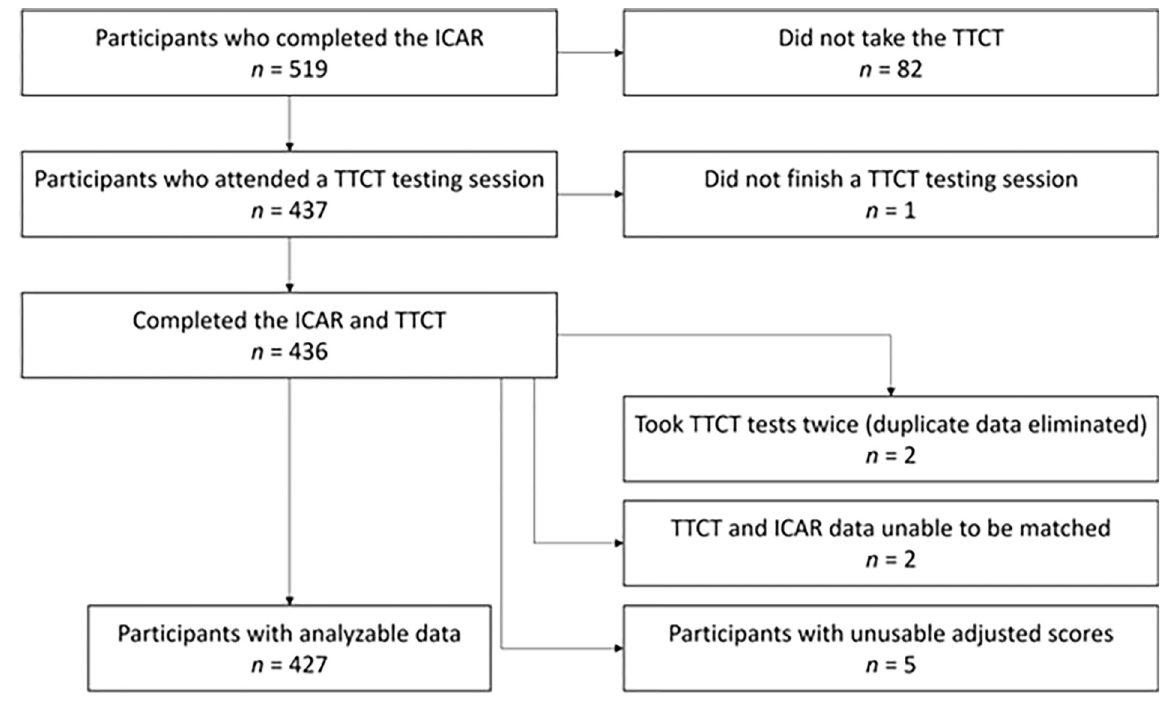
Fig 1. Subject flow diagram for the